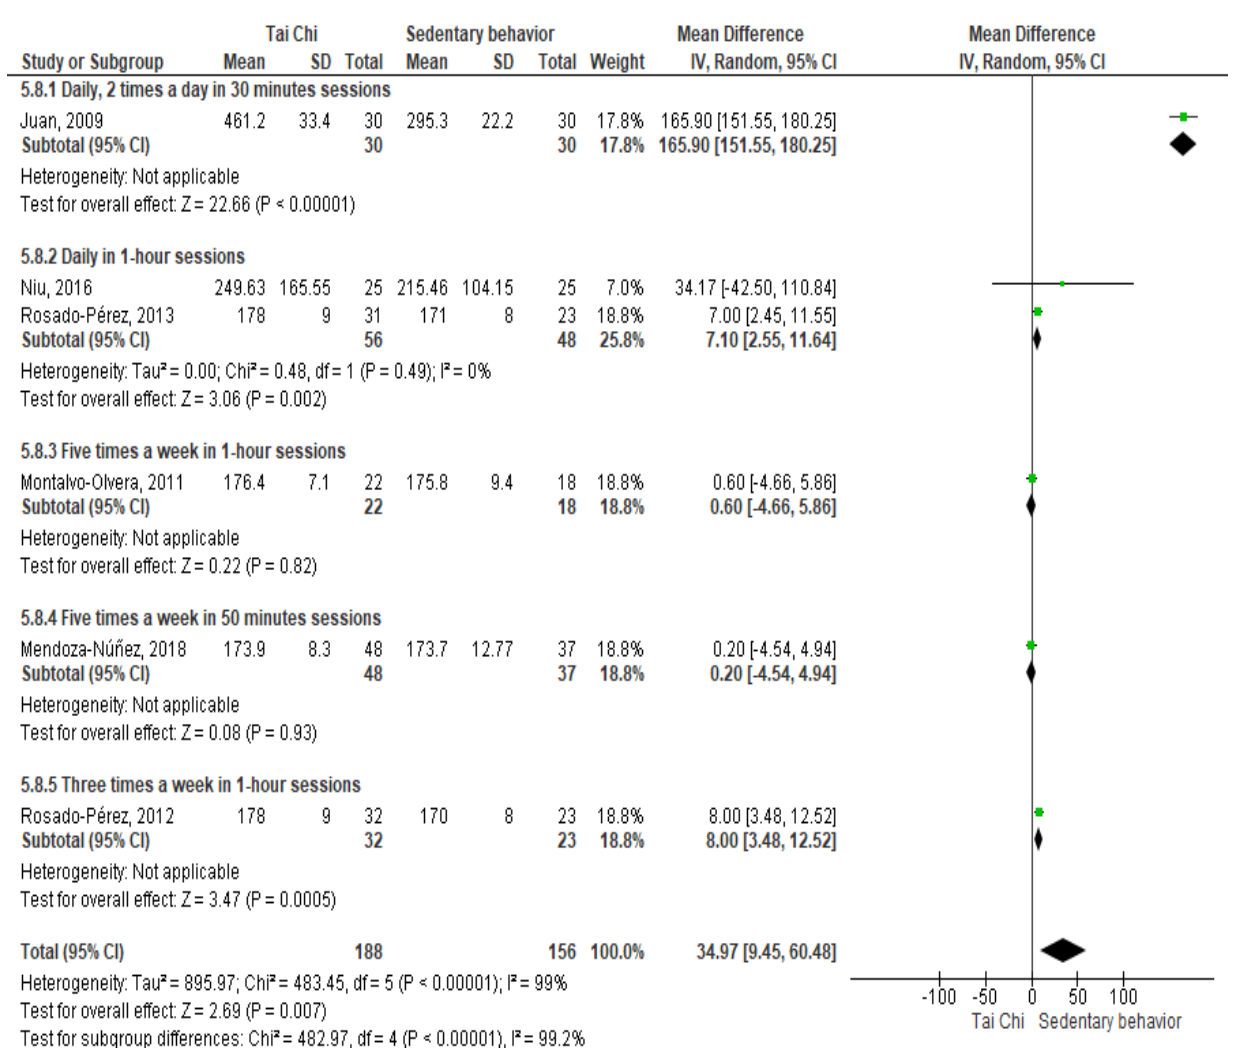
Figure 2. Forest plot of mean difference summary of the effect of Tai Chi on superoxide dismutase activity in comparison with sedentary behavior. The sub-analysis was performed according to the Tai Chi sessions per week.